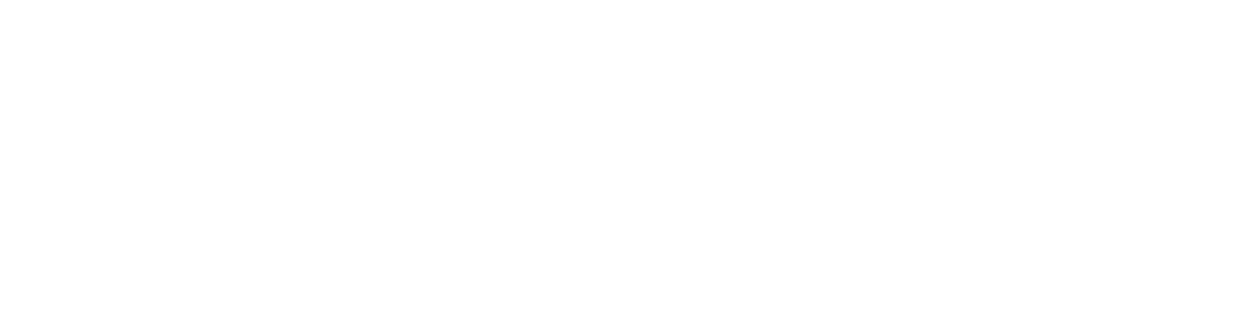
FIGUREA2 | CD4/CD8T cell profile of MOG 35–55 -immunized mice .The dot plots show the percentages of CD4 + and CD8 + T cells in the spleen of control or MOG 35–55 -immunized mice sacrificed at the indicated time points.The results are representative of n = 6–8